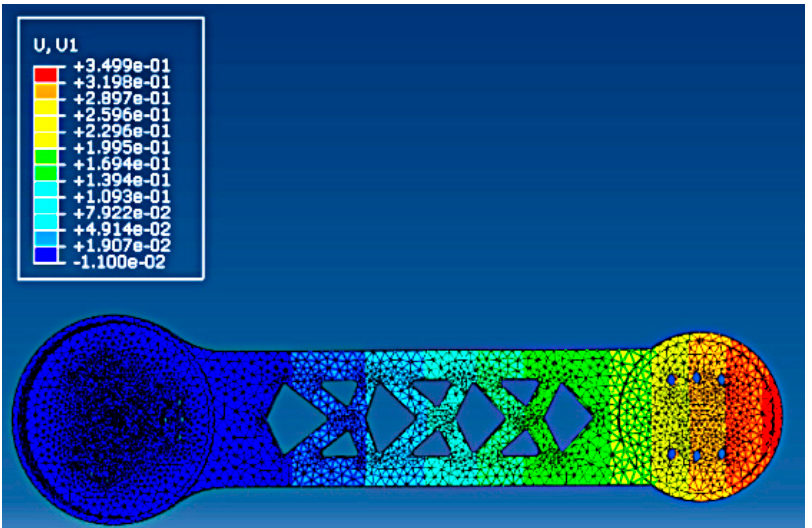
Figure 25. The maximum displacement of the gyration center in the most unfavorable working condition.